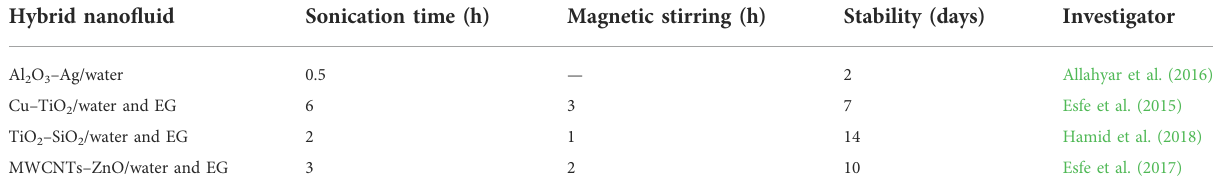
TABLE 2 Recent work on various hybrid